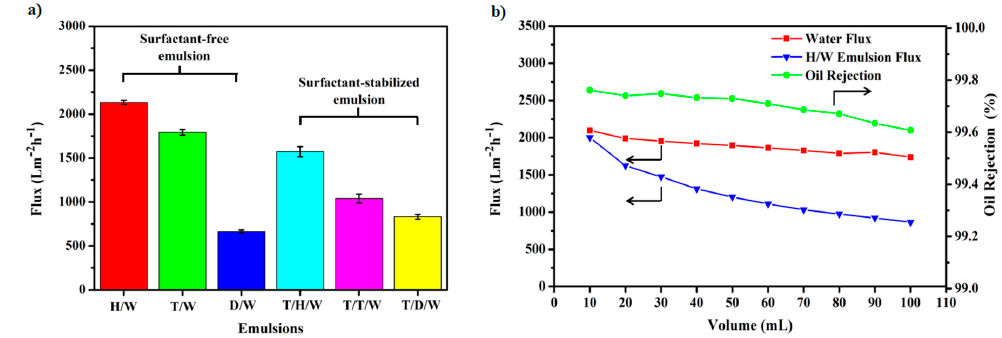
Figure 8. ( a ) Permeate flux for various emulsions of the CSPNM; ( b ) continuous separation flux for water and H/W emulsion of the CSPNM, and oil rejection of the CSPNM for continuous separating H/W emulsion.